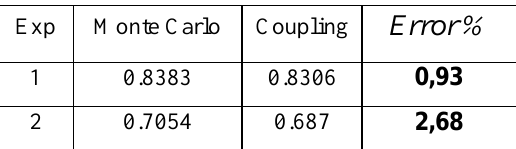
Table 2. Average outputs for the equivalent station for an Extended Kanban system